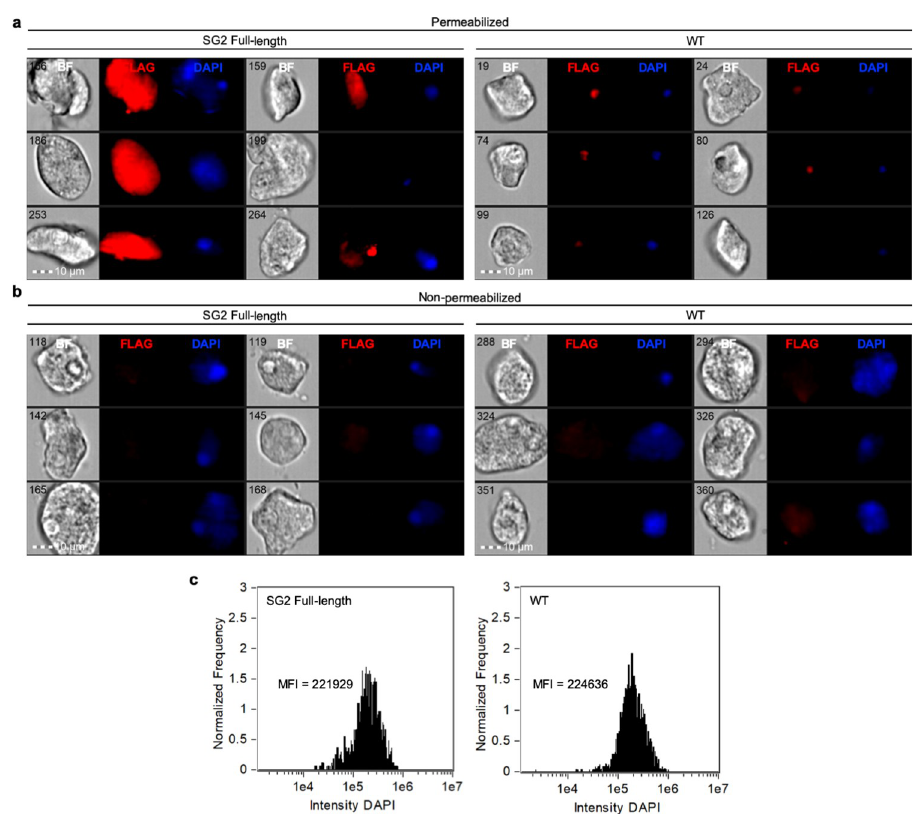
Fig 7. SG2 localizes to the cytoplasm. Amoebae were stably transfected with a plasmid for expression of full-length FLAG-tagged SG2. Immunofluorescence was used to determine the localization of SG2 in heterogeneous transfectants and imaging flow cytometry was used for analysis. a, Localization of SG2 in FLAG-SG2 transfectants (left panel) and control staining of wild-type cells (right panel). Samples were permeabilized prior to antibody staining. Six random cells are shown for each condition. Shown from left to right are bright field images (BF), mouse anti-FLAG antibody staining (FLAG, red), and DAPI staining (DAPI, blue). The numbers in the BF images indicate the object/image number. b, Localization of SG2 in FLAG-SG2 transfectants (left panel) and control staining of wild-type cells (right panel), as in panel A, except samples were not permeabilized. c, Histograms showing the intensity of the DAPI staining in images collected from FLAG-SG2 transfectants (left panel) or wild-type cells (right panel). The mean fluorescence intensity (MFI) is indicated on each histogram.